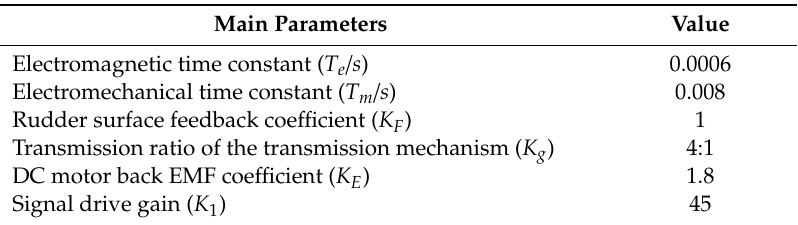
Figure 2. ASMC-03B electric steering gear. Table 1. Main parameters of the ASMC-03B electric steering gear.